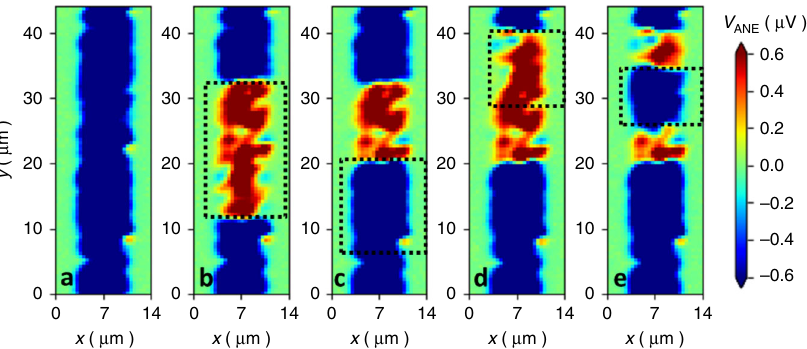
Fig. 4 Domain writing. Sample polarized to single domain ( a ). In panels b – e the area depicted by a dashed line was written using a laser power of 50 mW and the corresponding polarity of 0.5 T magnetic fi eld prior to the STGM scan ( + 0.5 T yields blue contrast and − 0.5 T yields red contrast). Writing was followed by reading with laser power of 10 mW. The whole sequence was performed at